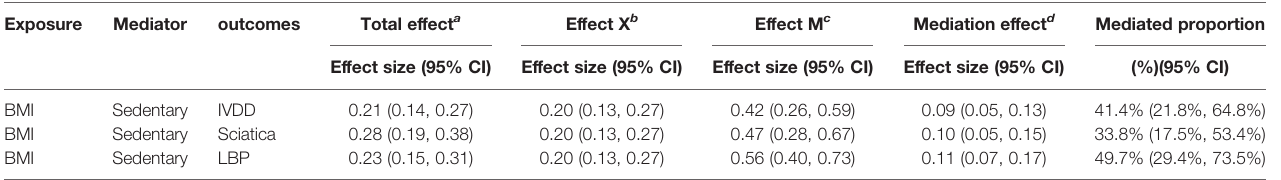
TABLE 1 | Proportion of BMI ’ s effect on IVDD, sciatica, and LBP mediated by sedentary behavior.